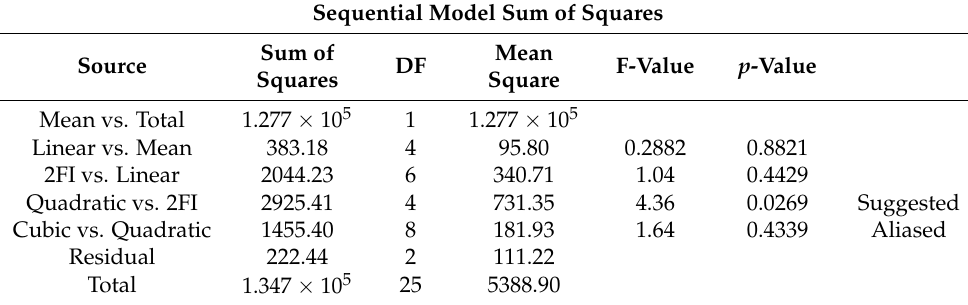
Table 3. The model analysis of this study.